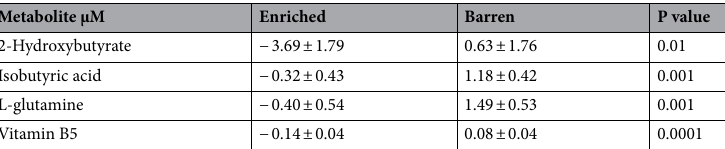
Table 3. Least squared means and SE of the significant magnitude of change (delta) of metabolite concentration of pigs that were housed in enriched and barren environments after regrouping at 9 weeks of age.